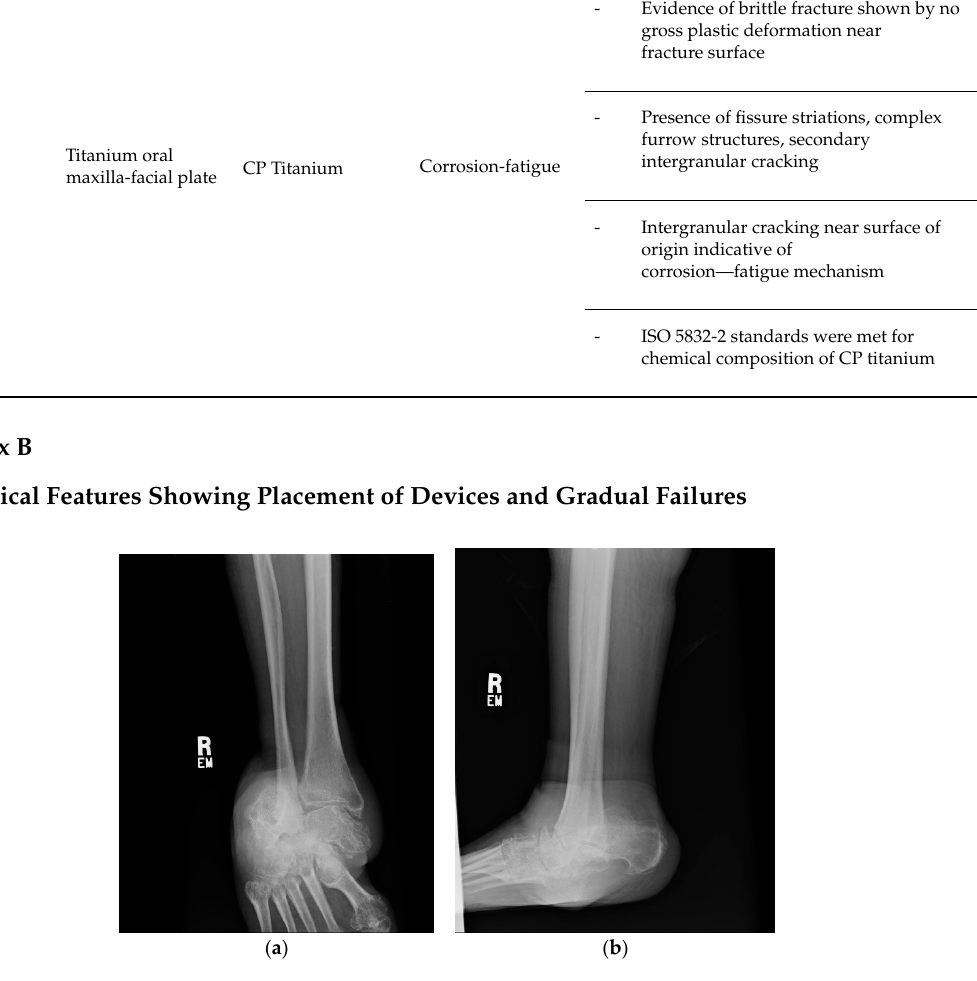
Figure A1. Initial X-Ray images showing lateral subtalar dislocation with varus tibiotalar joint alignment. Metals 2018 , 8 , x FOR PEER REVIEW